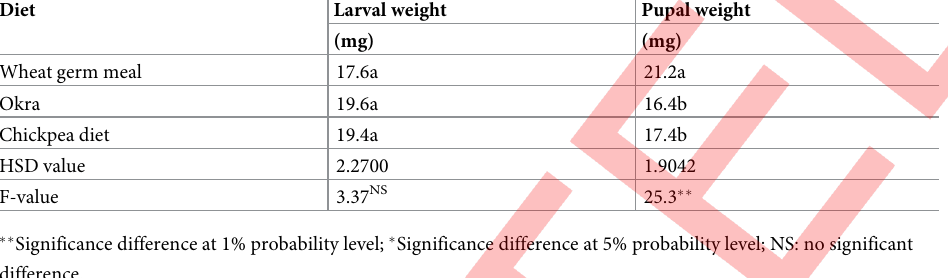
�� Significance difference at 1% probability level; � Significance difference at 5% probability level; NS: no significant